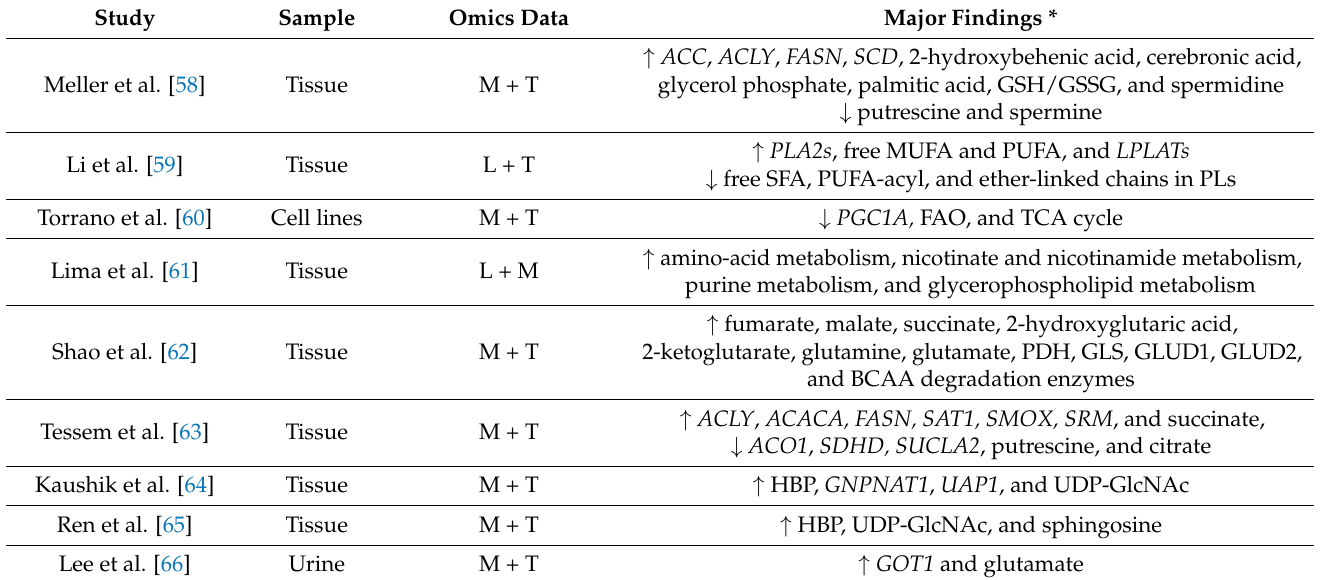
Table 1. Most relevant metabolic alterations reported in recent multi-omics studies focused on the characterization of the specific metabolic phenotype of PCa